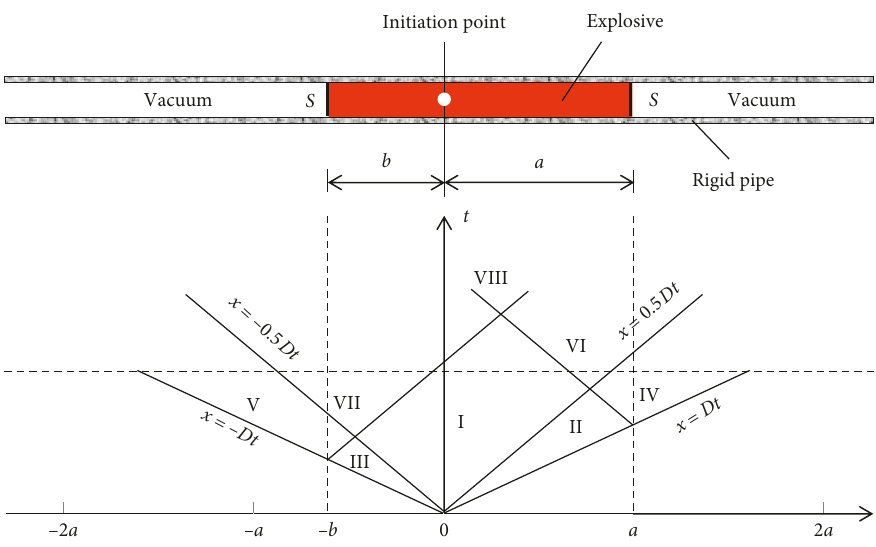
Figure 3: One-dimensional flow model of the cylindrical charge and the partition of flow fields.